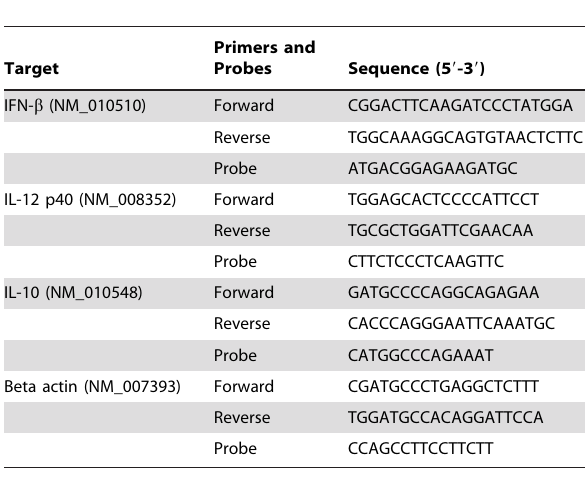
Table 1. Primers and Probes used for Real-Time PCR